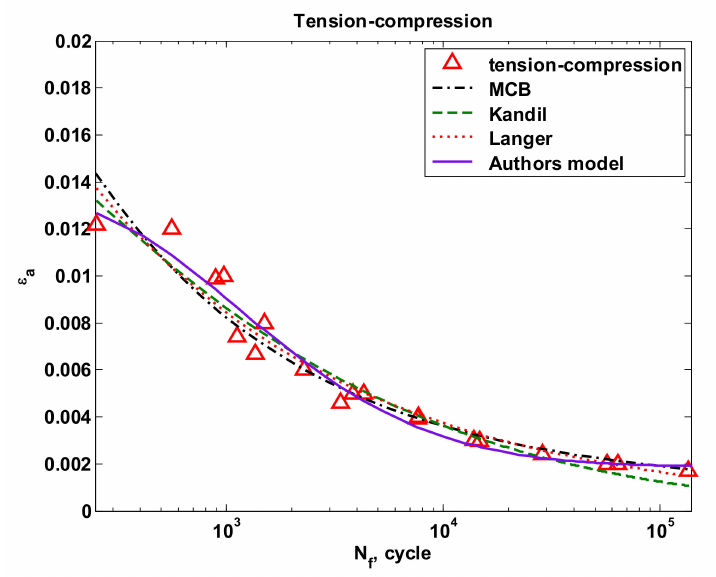
Figure 12. The strain amplitude for individual models under tension-compression.